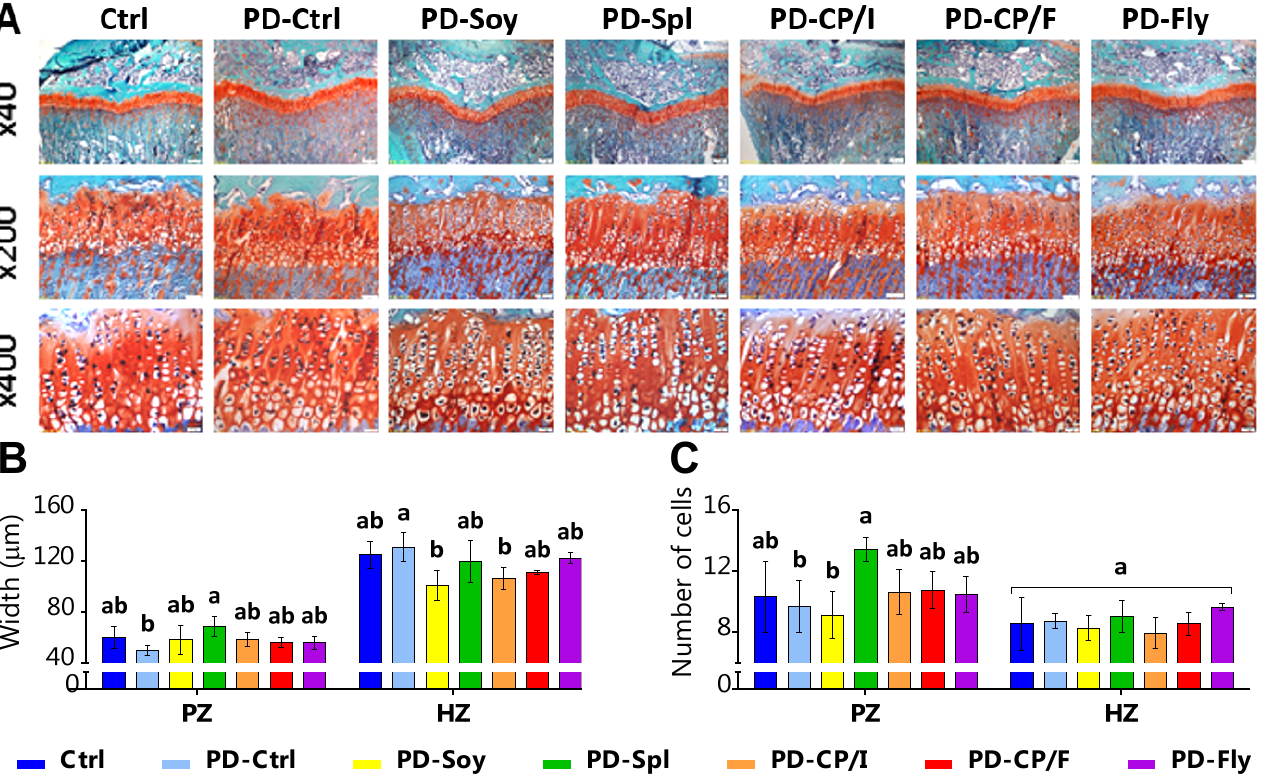
Figure 2. Histological evaluation of the tibial growth plates of 9-week-old rats. Transverse tissue sections of 5 µ m were prepared by microtome. GP width and number of cells have been measured in cell A software at 10 selected locations. ( A ) Safranin-O staining of the tibial GP. ( B ) GP zones’ width ( µ m). ( C ) GP zones’ number of cells. GP, growth plate; PZ, proliferative zone; HZ, hypertrophic zone. Values are expressed as mean ± SD of n = 4 samples/group, different superscript letters are significantly different ( p < 0.05) by one-way ANOVA followed by Tukey’s test.